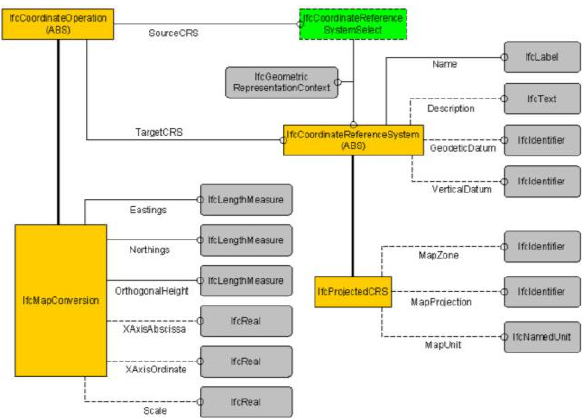
Figure 5 EXPRESS-G Diagram of the IFC (version 4) coordinate operation